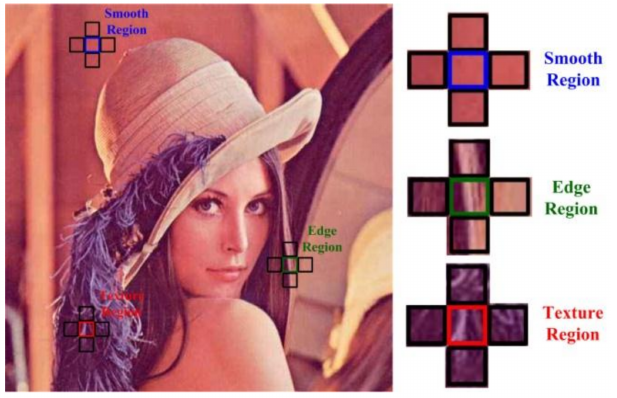
Figure 2. Illustration of visual contrasts among blocks on smooth, edge and texture regions of Lenna . Note that the size of block is 16 × 16.